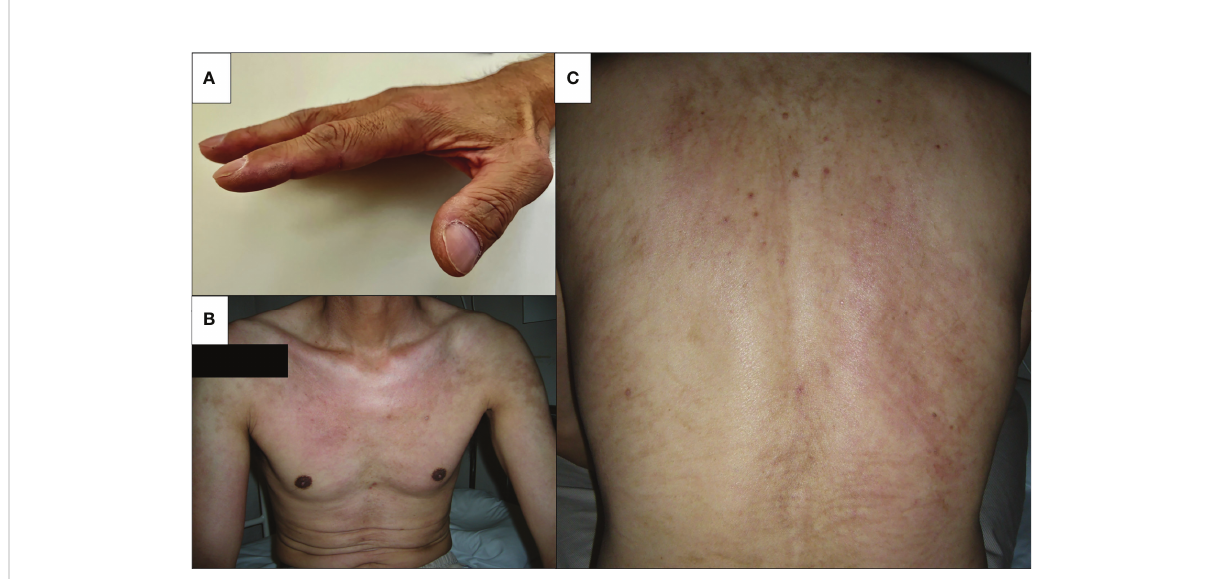
FIGURE 1 Skin fi ndings on admission. Physical examination revealed skin manifestation of dermatomyositis. (A) Mechanic ’ s hand, (B) V-neck sign on the chest, and (C) whiplash-like erythema on the